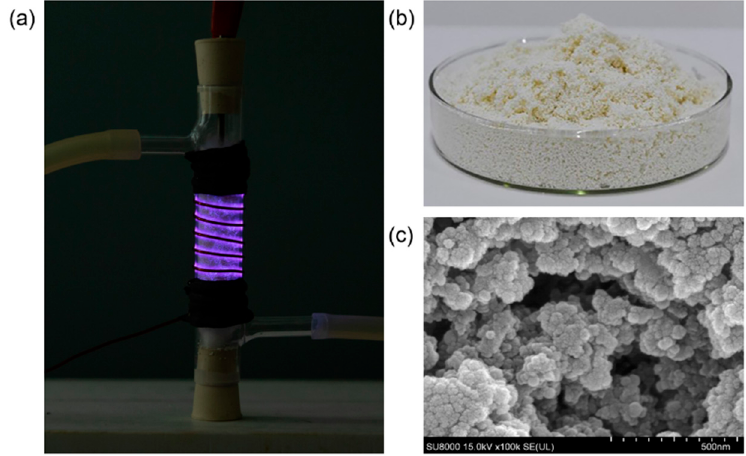
Figure 1. Preparation of MPP and its microstructure. ( a ) Plasma modification of MaPR; ( b ) MPP; ( c ) SEM images of MPP magnified to 500 nm.